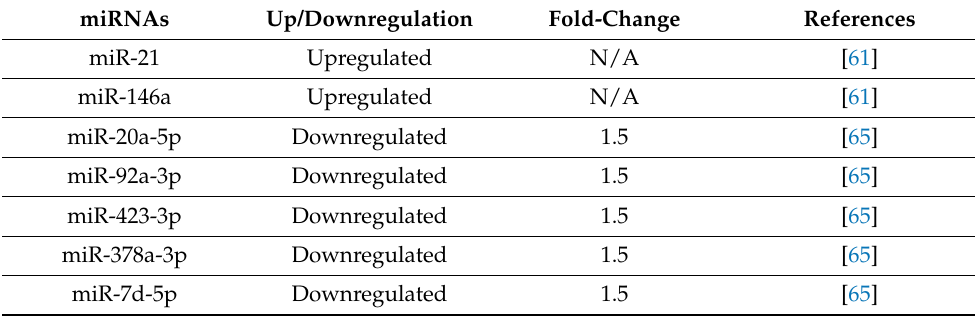
Table 2. EV-associated biomarkers in cervical